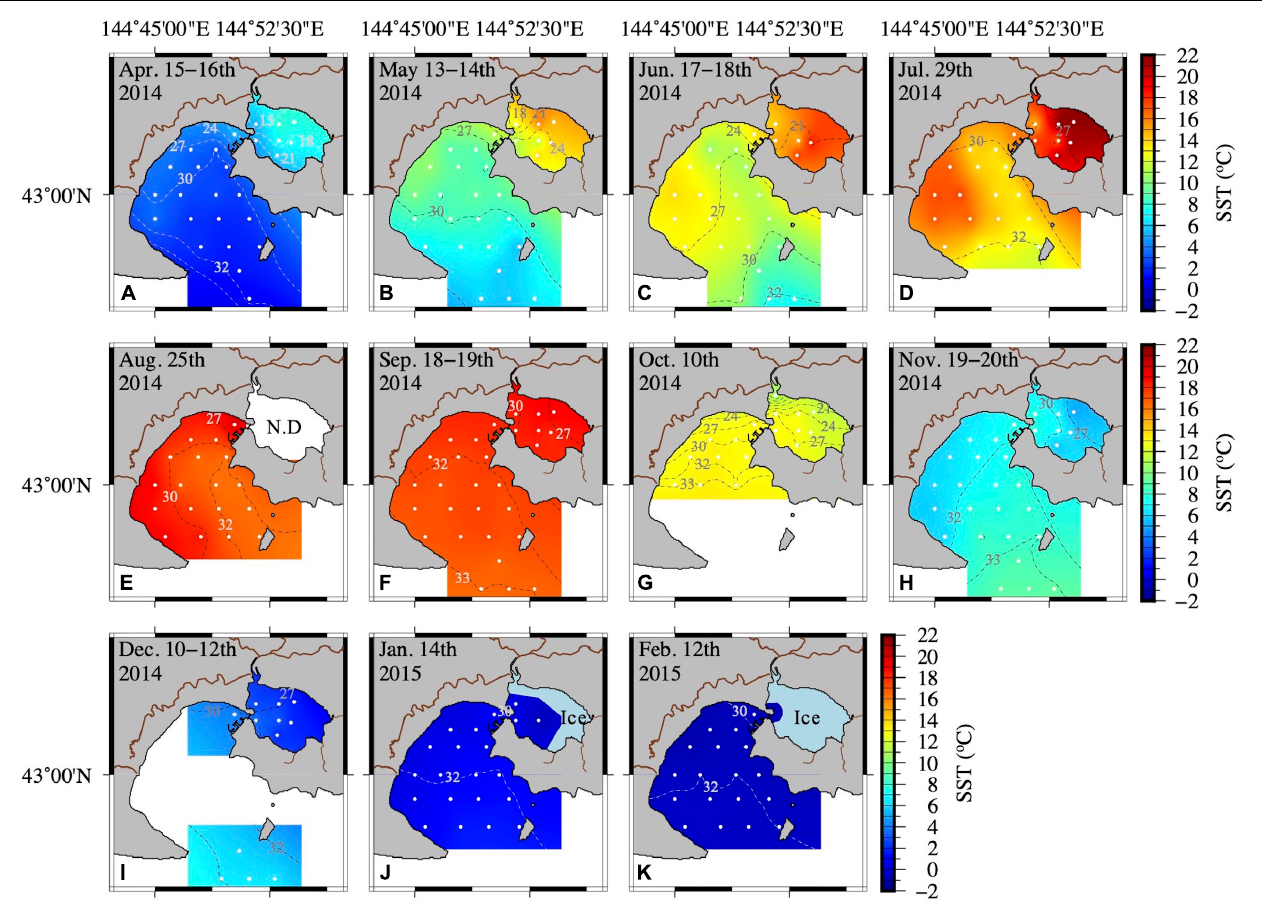
FIGURE 2 | Spatial distribution of seawater temperature and salinity at the surface (A–K) from April 2014 to February 2015. Inter- and extrapolation of temperature and salinity were implemented by the General Mapping Tools. White symbols and dashed lines in each figure represent the sampling sites and salinity, respectively.